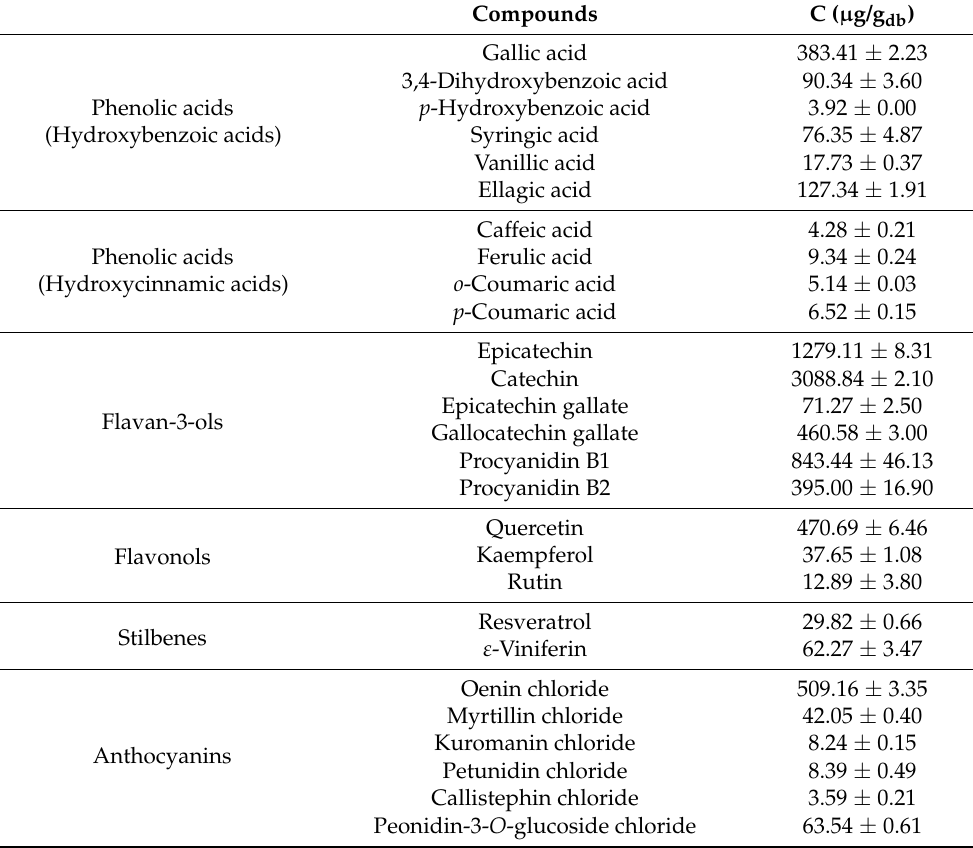
Table 5. Content of individual phenolic (C) in GP extract determined by UHPLC analysis.